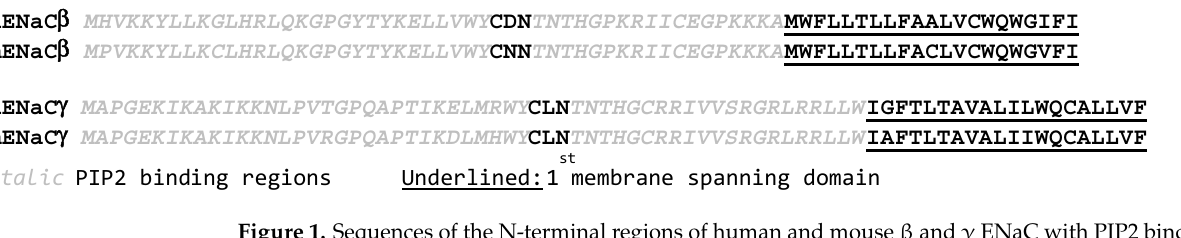
Figure 1. Sequences of the N-terminal regions of human and mouse β and γ ENaC with PIP2 bind- ing domains and transmembrane-spanning domains marked.